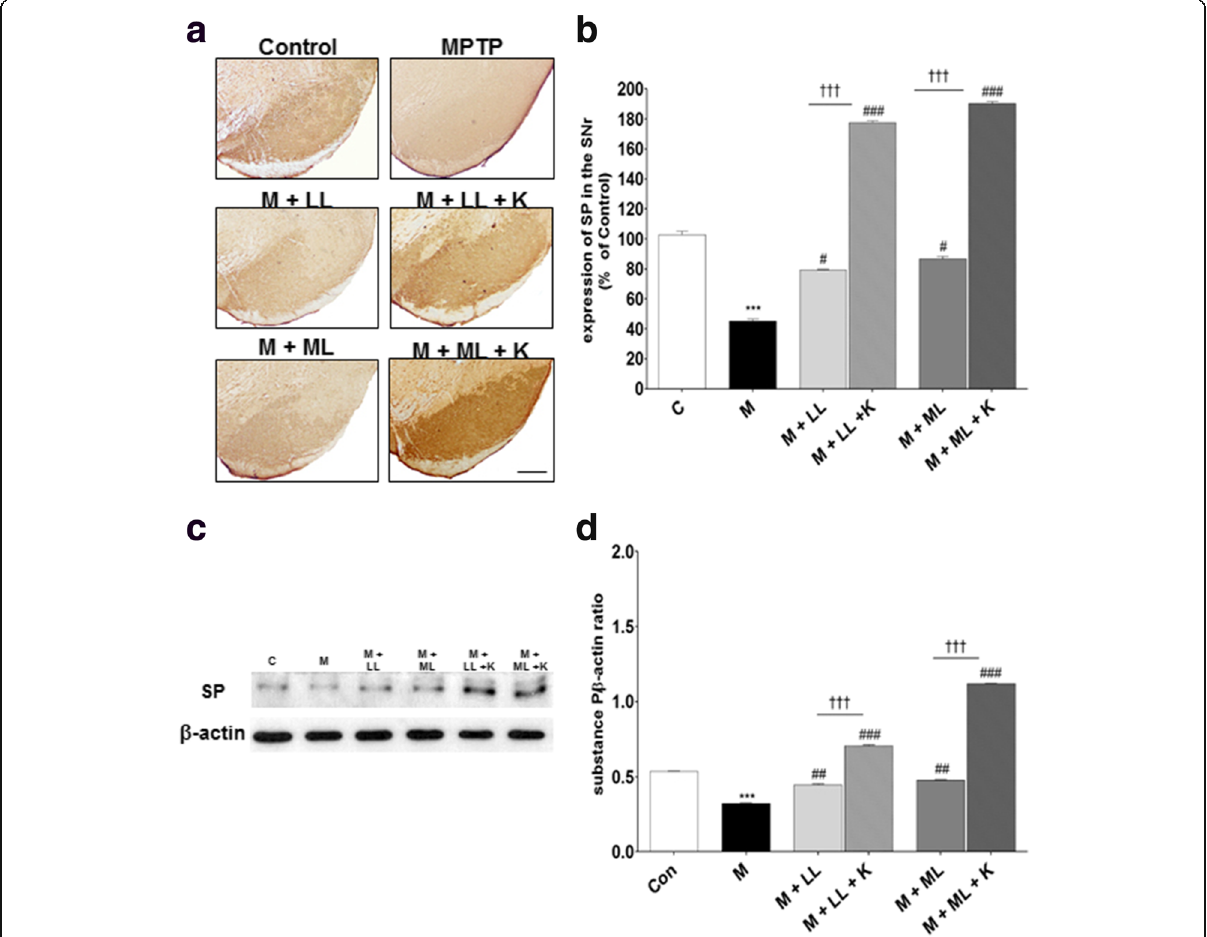
Fig. 6 Effects of combination treatment on SP expression in the SNr. Immunohistochemical analyses of SP expression in the SNr ( a , b ). Western blot analyses of SP expression in the SNr ( c , d ). MPTP mice showed significantly lower SP expression in the SNr, whereas combination treatment significantly increased SP expression in the SNr. C: control, M: MPTP, K: KD5040, LL: low dose of (10 mg/kg). *** p < 0.001 vs. control, ### p < 0.001 and # p < 0.05 vs. MPTP, and ††† p < 0.01 vs. each dose of